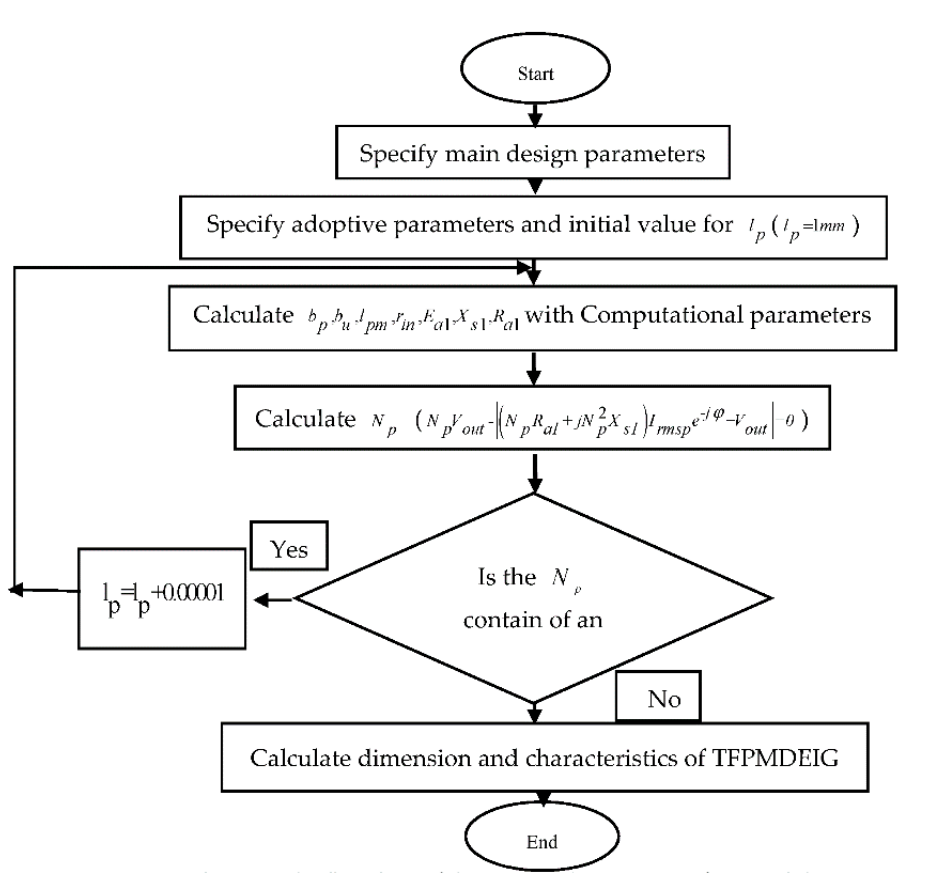
Figure 10. The flowchart of the proposed TFPMDEIG for initial design.